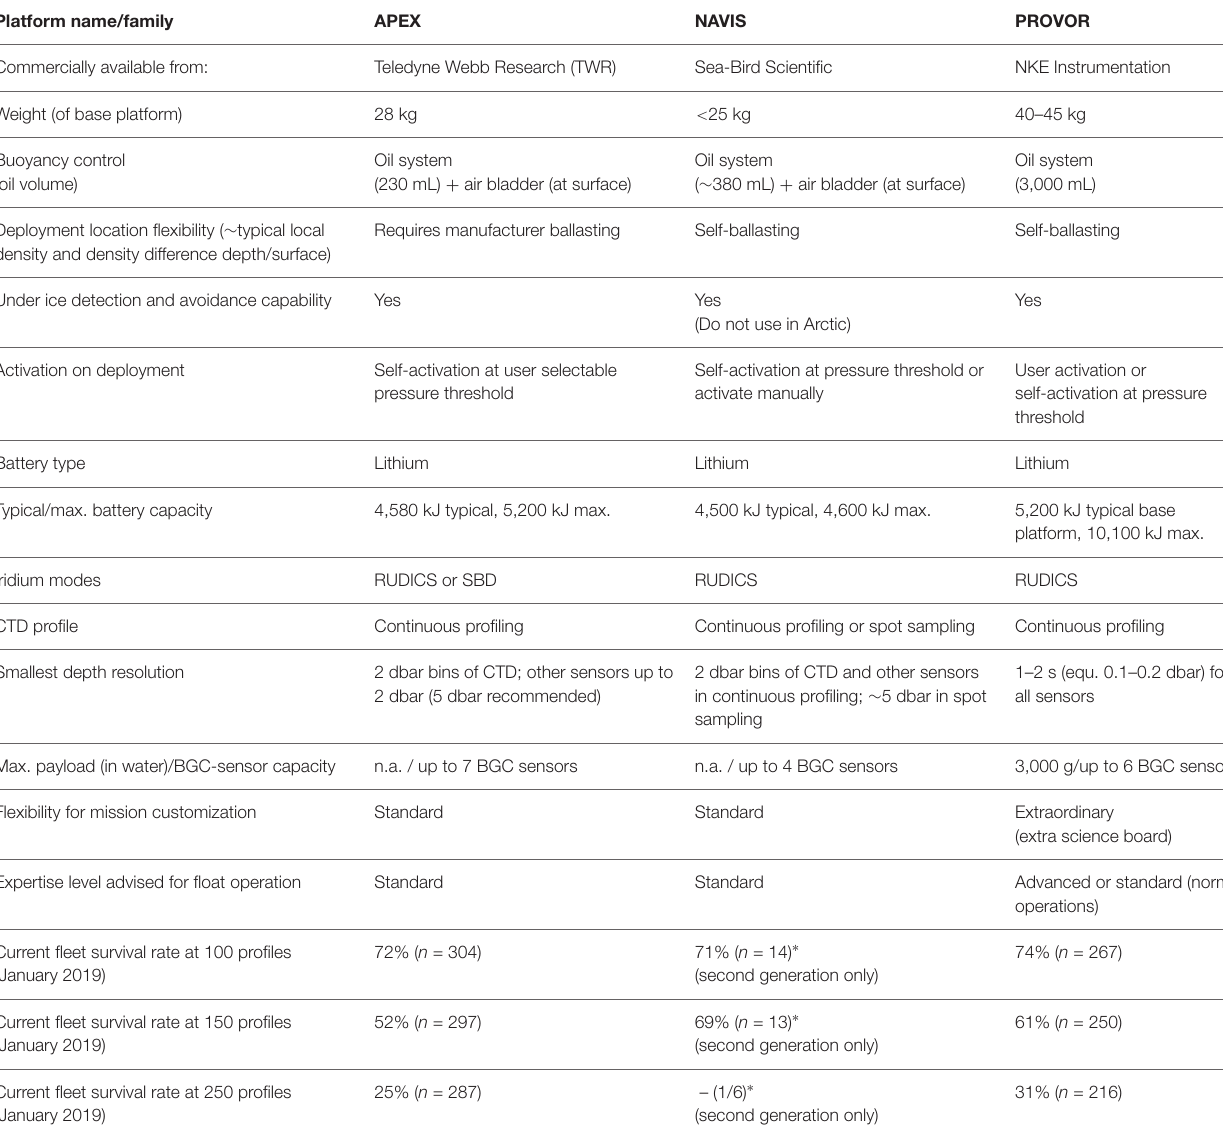
TABLE 2 | Qualitative comparison of common, commercially available BGC-Argo float